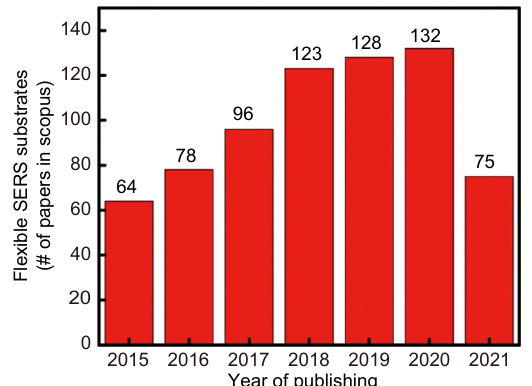
Fig. 3 | Year wise publications on flexible SERS substrates ob- tained through a search in